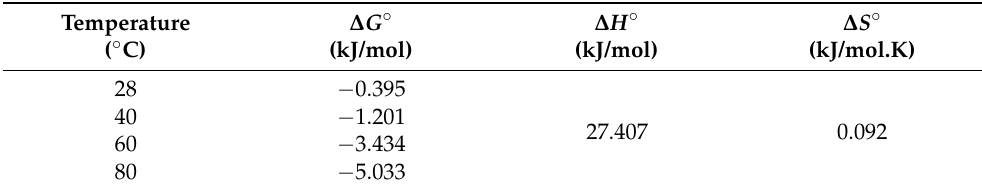
Table 4. Adsorption thermodynamics for the removal of Cr(VI) from aqueous solution using CNCs as an